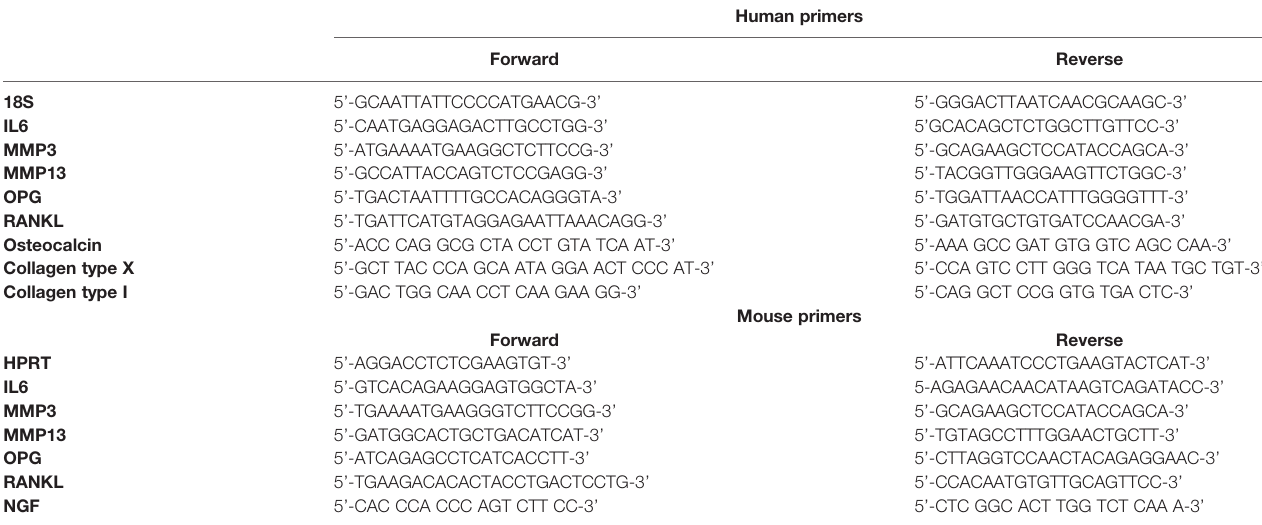
TABLE 1 | List of human and mouse primers used for qPCR